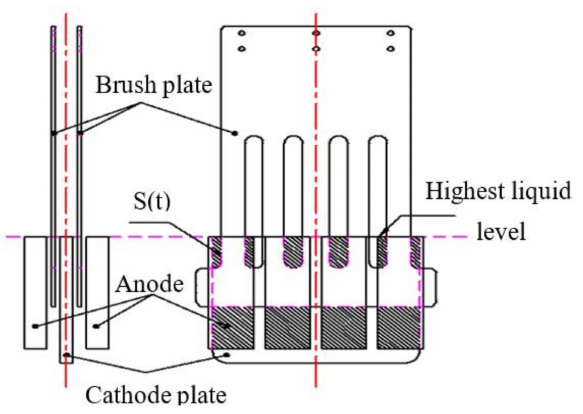
Figure 4. Schematic diagram of normal flow surface between cathode and